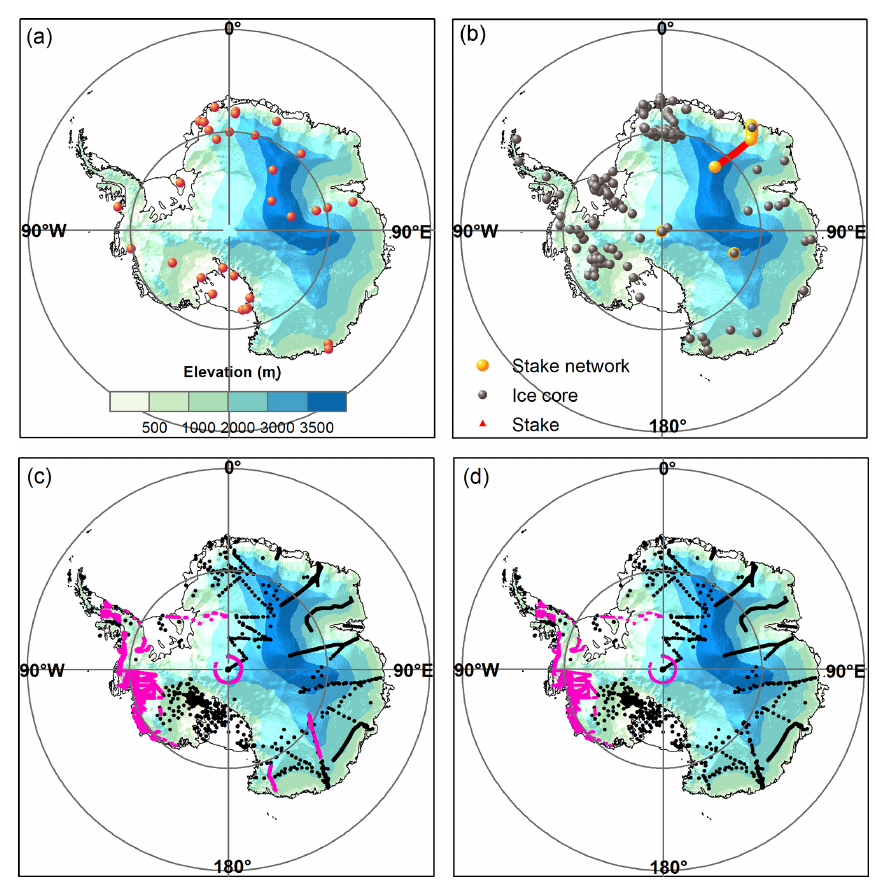
Figure 1. The comprehensive dataset of Antarctic SMB observations. (a) Spatial distribution of available AWS observations. (b) Locations of available annually resolved SMB observations. (c) Locations of available multi-year-averaged SMB field data. Purple five-pointed stars standard for GPR measurements. Black points represent reliable SMB determined by stakes/stake farms and ice cores/snow pits. (d) Location of multi-year-averaged SMB data only during the second half of the 20th century selected for model